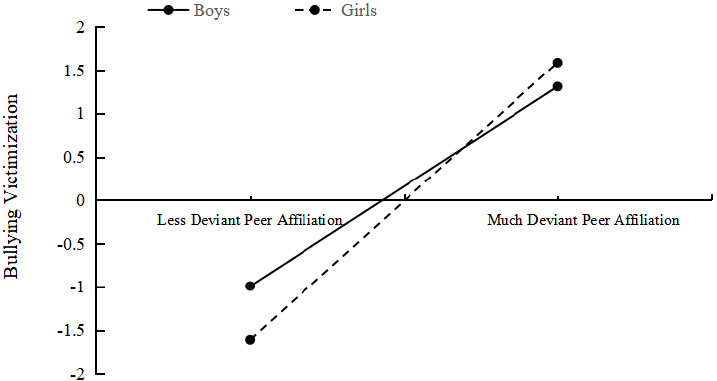
Figure 3. Interaction effect between deviant peer affiliation and gender on victimization.